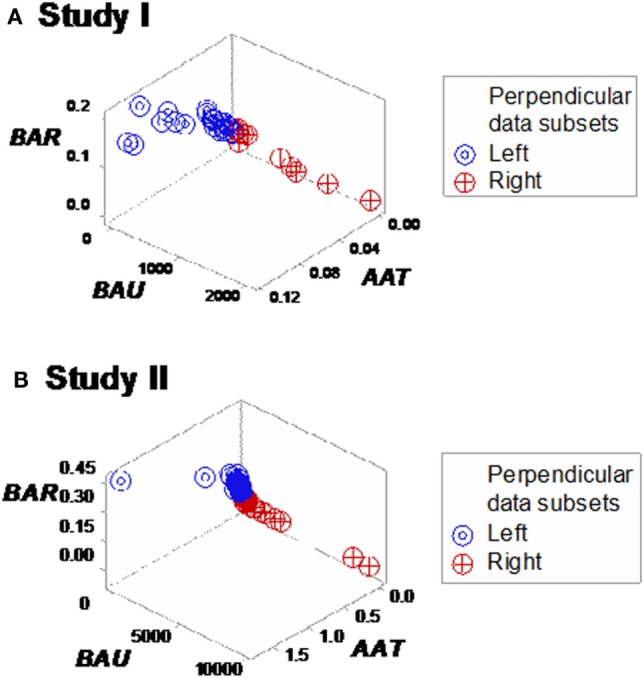
Three-dimensional (combinatorial and partitioning-oriented) analysis of dimensionless indicators derived from leukocyte data (structure I). The large number of combinations the alternative method can generate increased the likelihood of finding some informative plots. Both study I (A) and II (B) displayed a single (one data point-wide) line of observations, which consisted of two segments perpendicular to one another. Such graphic data structure improves detection because data points can only occur along the line.